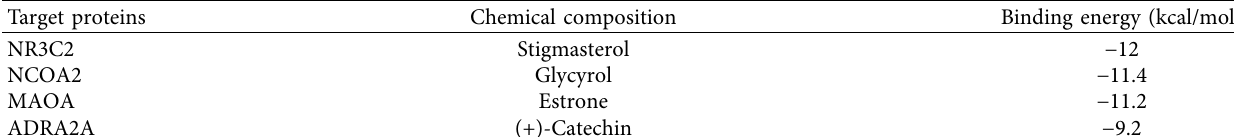
Table 4: Molecular docking